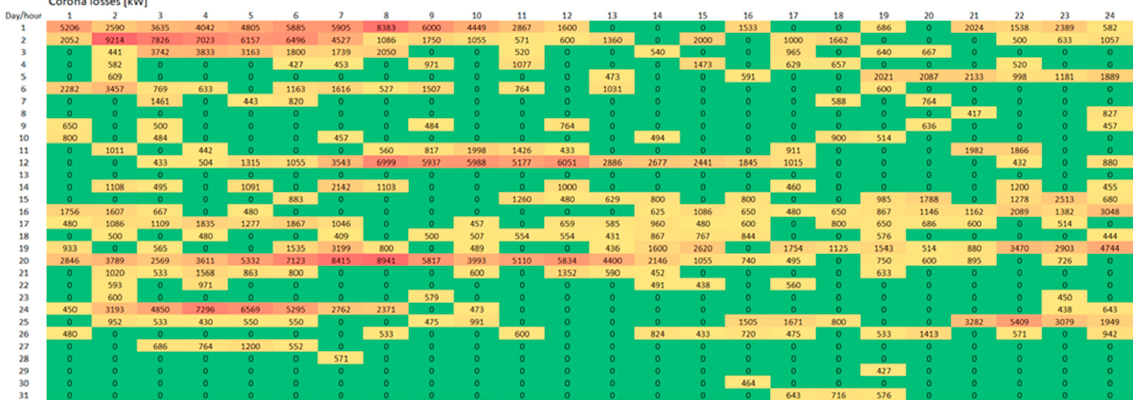
Figure 12. Total losses (kWh) on an hourly basis for the observed 400 kV transmission grid (heat map) for a 30-day period and for each hour of the day.